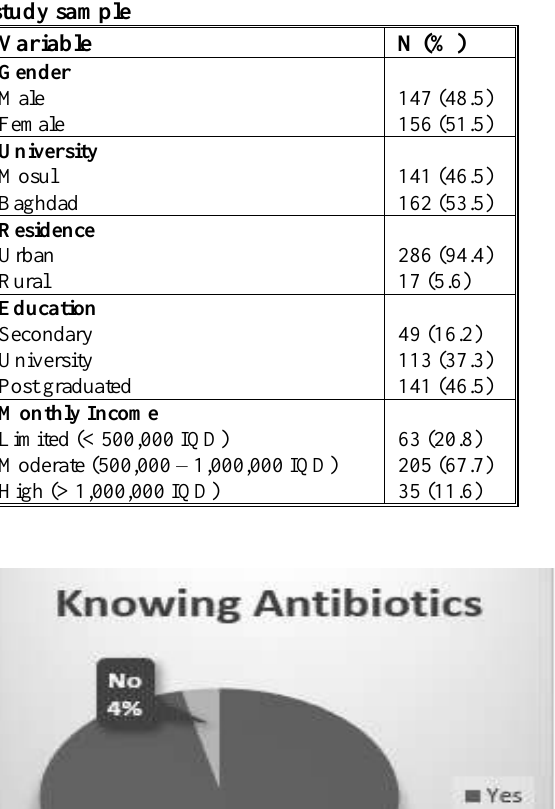
Table 1. Demographic characteristics of the